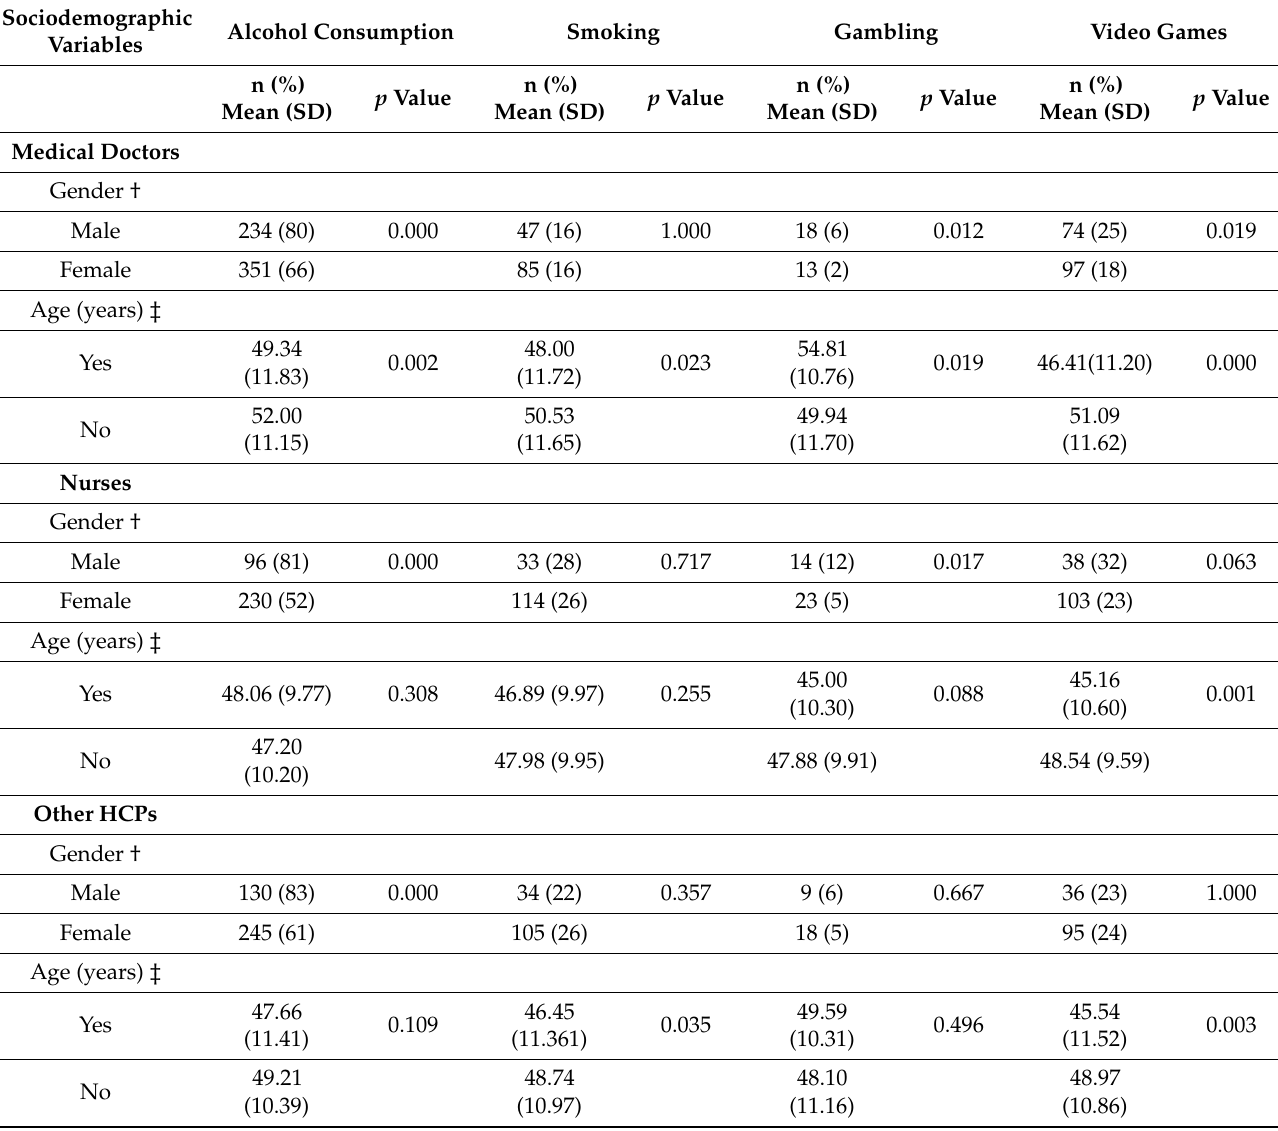
Table 2. Sociodemographic and behavioural variables during the first wave (post 11 March).